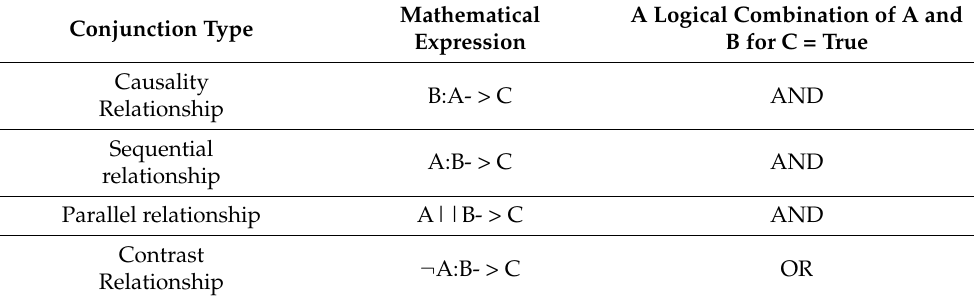
Table 5. Parts of Logical Expression of Conjunction.